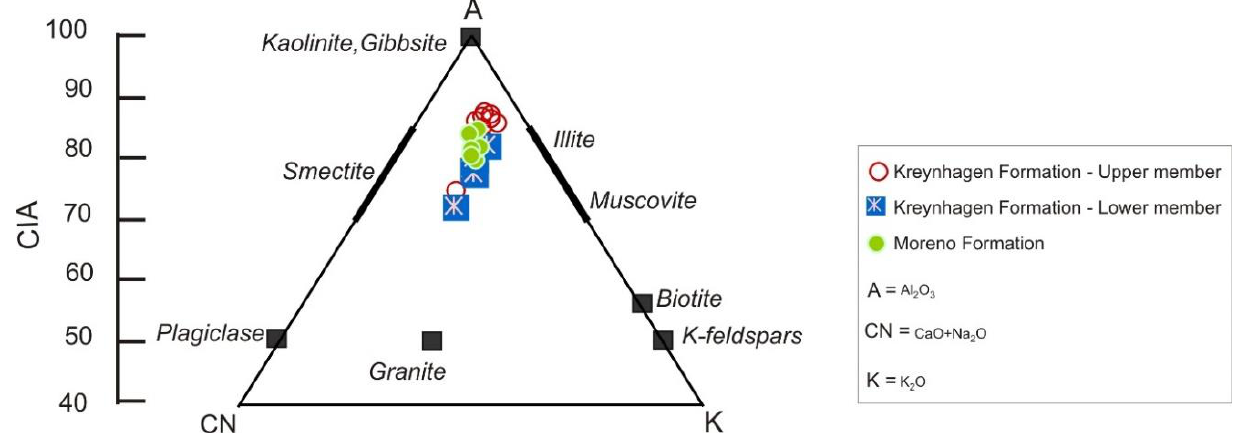
Figure 5. The A–CN–K plot of samples from Table 2 excluding those enriched in carbonate.